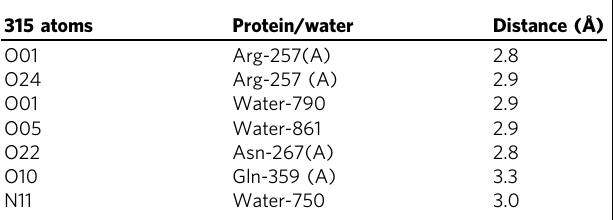
(cytosol) was loaded onto a 2ml column of nickel-NTA resin. The column was washed with buffer A and buffer B (50 mM imidazole, 20mM HEPES pH 8.0, 300 mM NaCl), and eluted with buffer C (100mM imidazole, 20 mM HEPES pH 8.0, 300 mM NaCl) and buffer D (500mM imidazole, 20 mM HEPES pH 8.0, 300 mM NaCl) respectively. The fractions containing efHMGR, identi fi ed by denaturing polyacrylamide gel electrophoresis (10% SDS PAGE), demonstrated a single protein band at ~50KDa. The fractions containing efHMGR were pooled together and precipitated by adding 3X volume of saturated ammonium sulfate